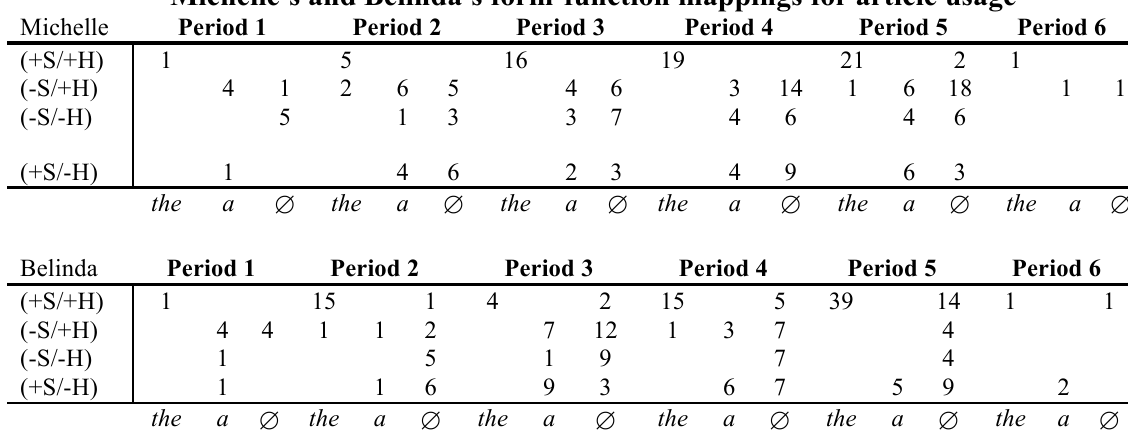
Michelle’s and Belinda’s form-function mappings for article